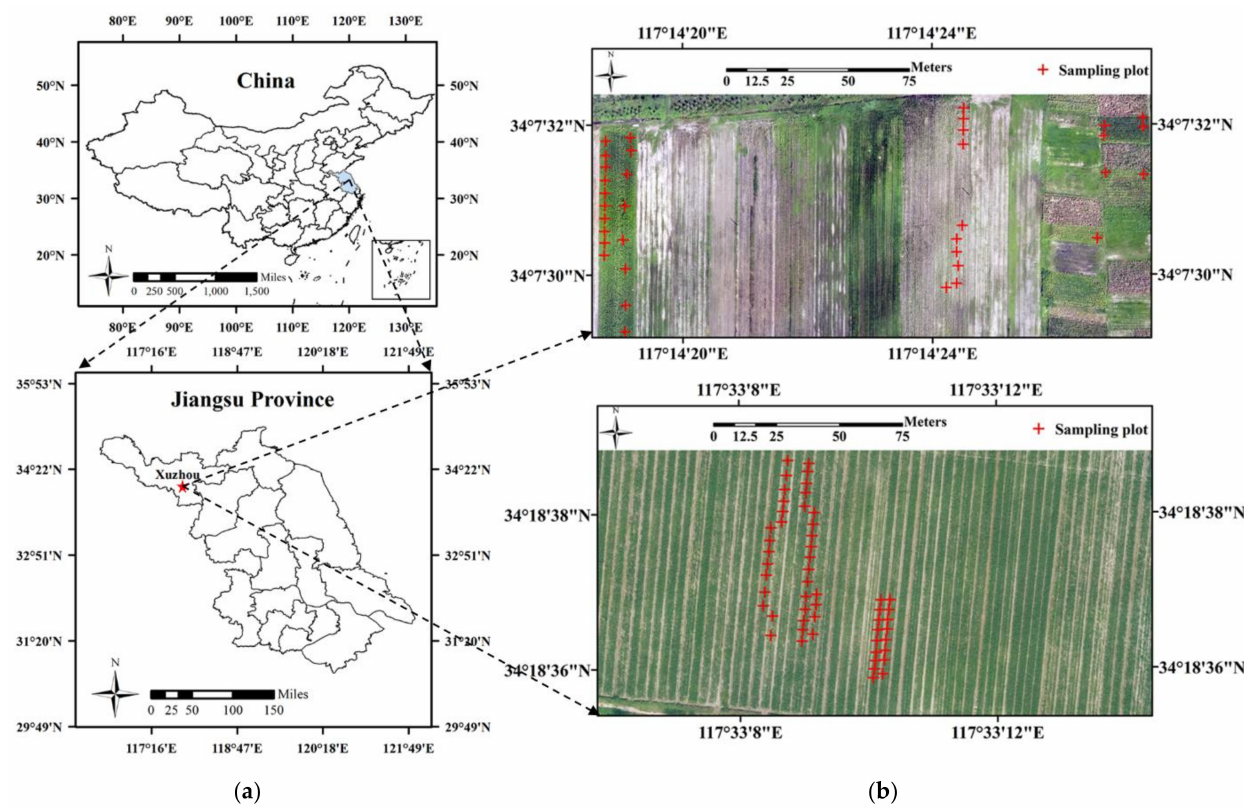
Figure 1. ( a ) Location of the experimental farm in this study and ( b ) general situation of some experimental fields and the distribution of LAI ground sampling points.